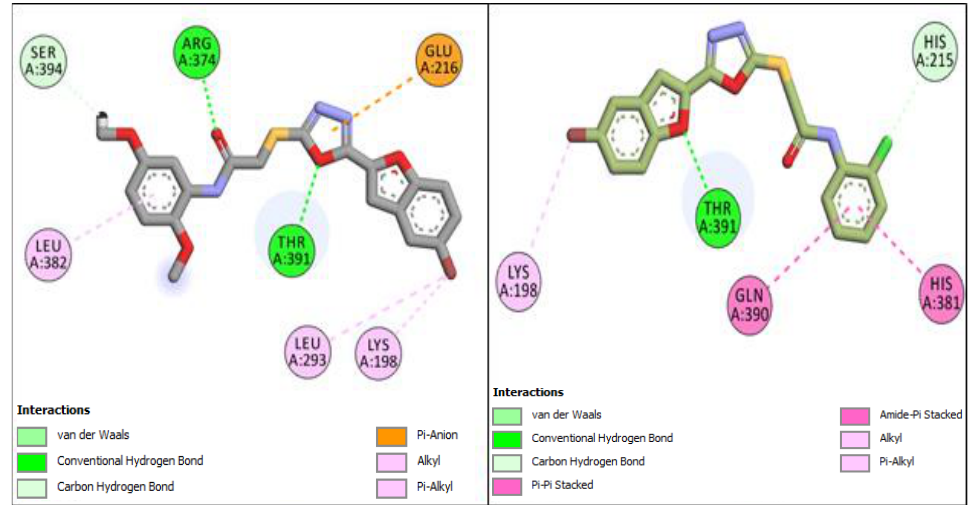
Figure 8. Two-dimensional conformational pose of BF4 with hTYRP1 ( Left panel ) and two- dimensional conformational pose of BF7 with hTYRP1 ( Right panel ).